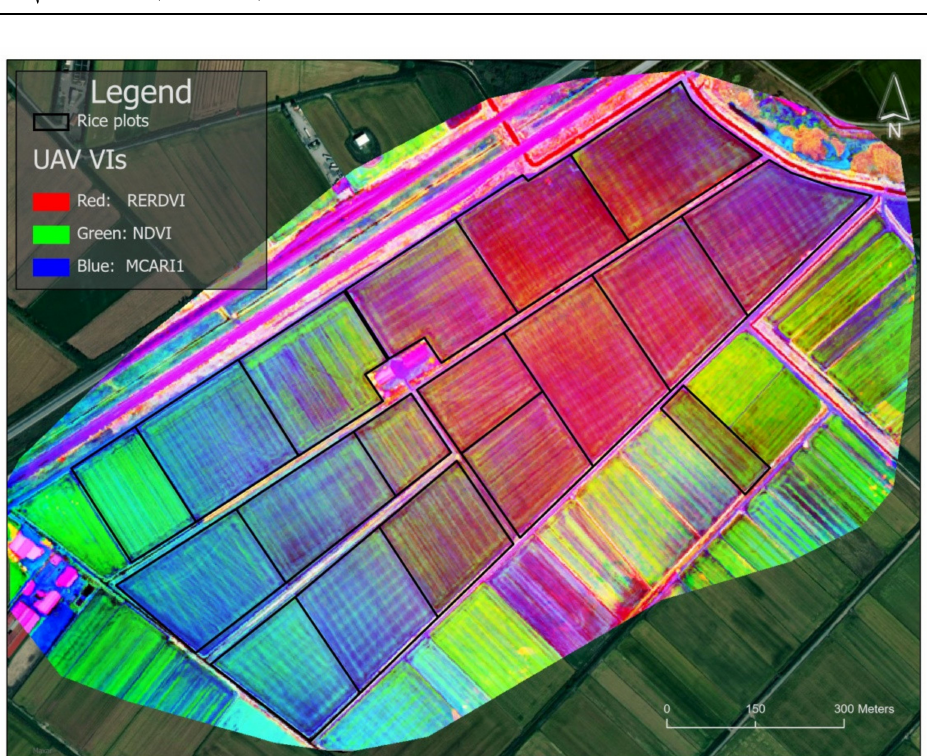
Figure 7. UAV vegetation indices imagery of rice plots (red band = RERDVI, green band = NDVI, blue band = MCARI), with color rendering representing the highest VI in each